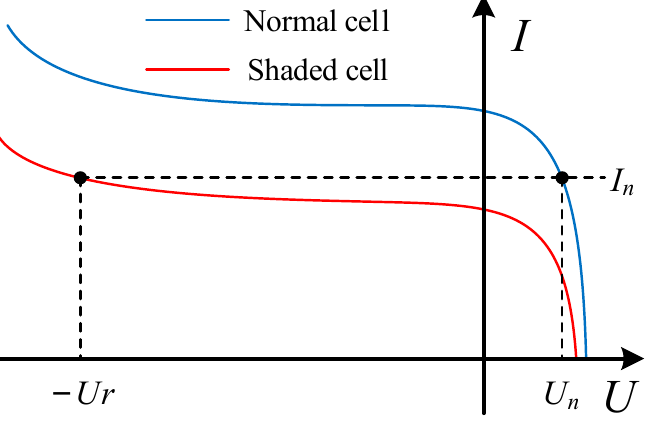
Figure 1. The internal wiring structure of the 300 W PV module.